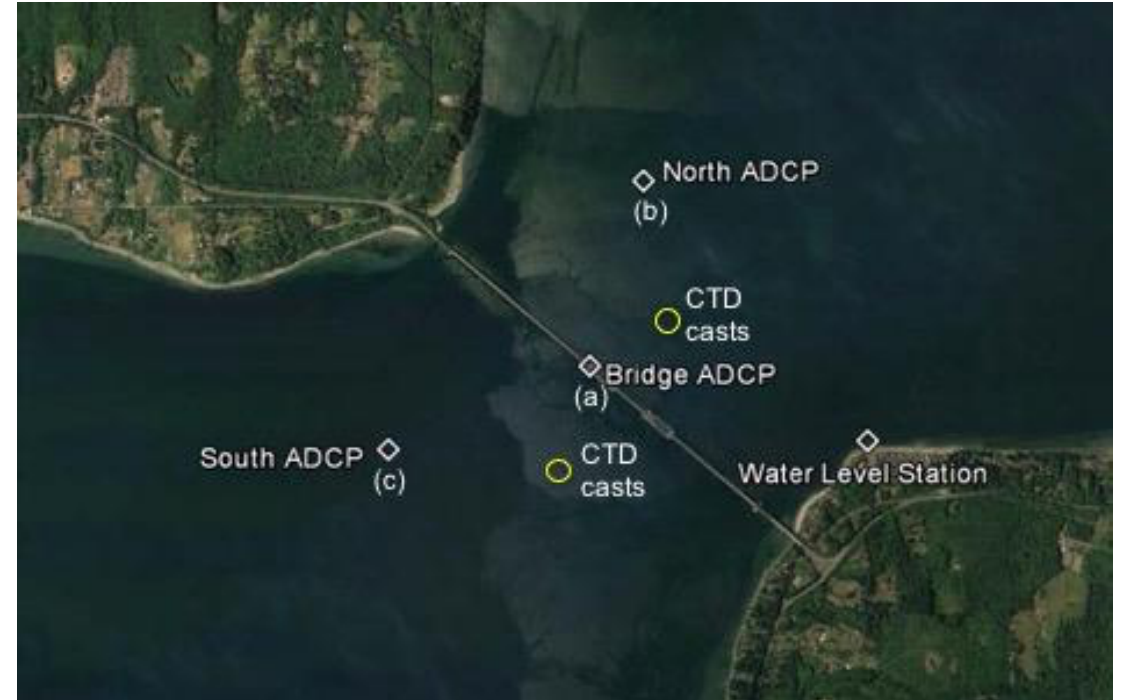
Figure 2. Hood Canal Bridge (HCB) study area showing the floating bridge and the 2017 oceanographic data collection program station locations relative to the bridge.